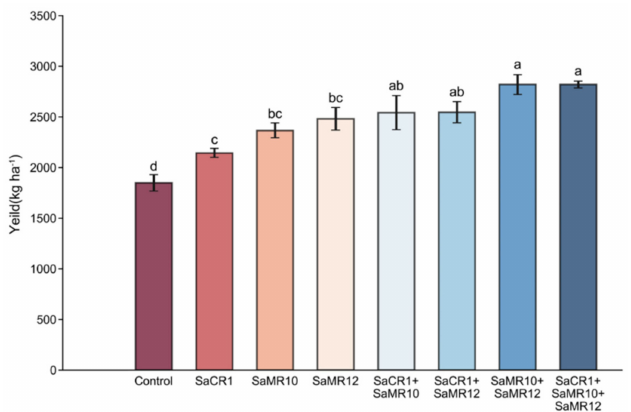
Figure 3. Effects of PGPB inoculants on the seed yield of B. juncea . The letters above the column indicate the significant differences among different treatments at p <